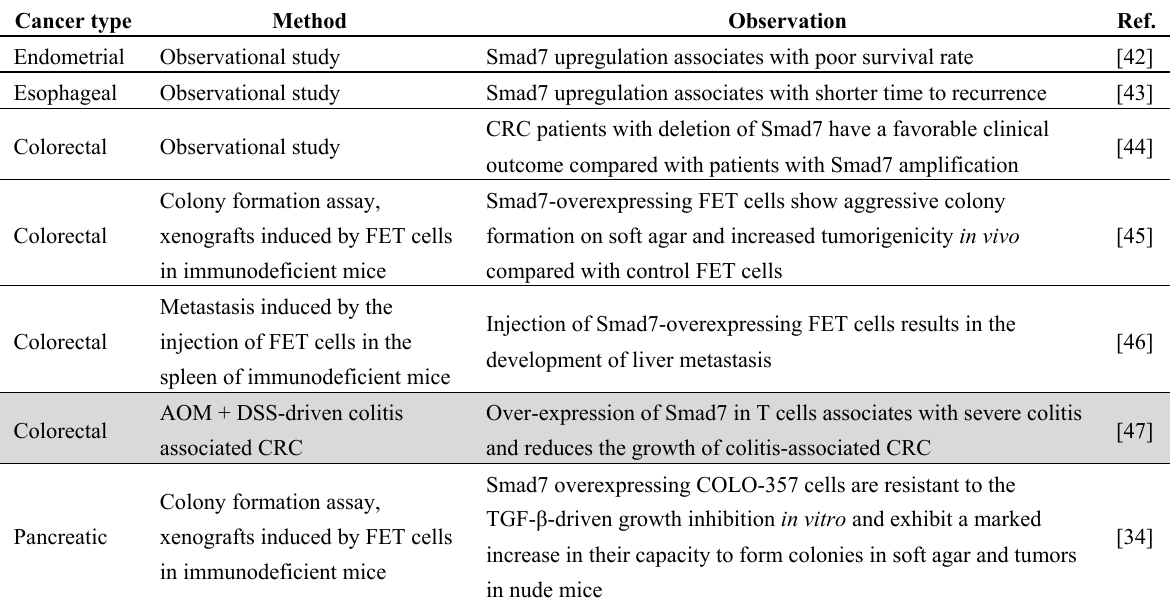
Table 1. Pro- and anti-tumor effects of